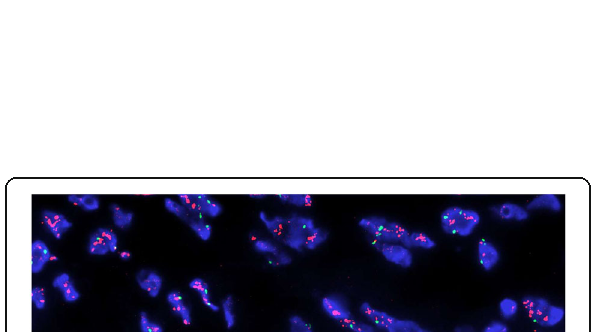
high proliferation